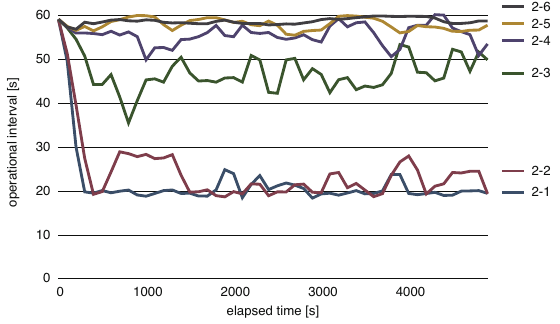
Figure 10. Temporal change of operational interval in stepwise